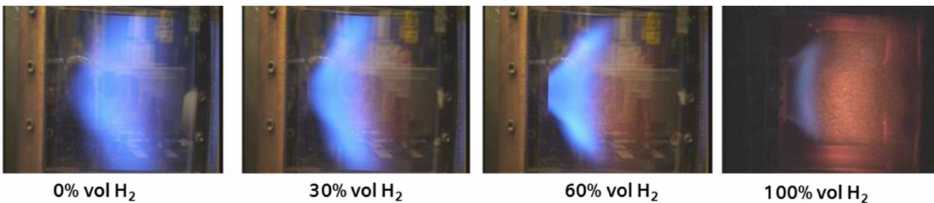
Figure 3. Change in the position of the flame with an increase in the hydrogen content of the fuel according to Siemens